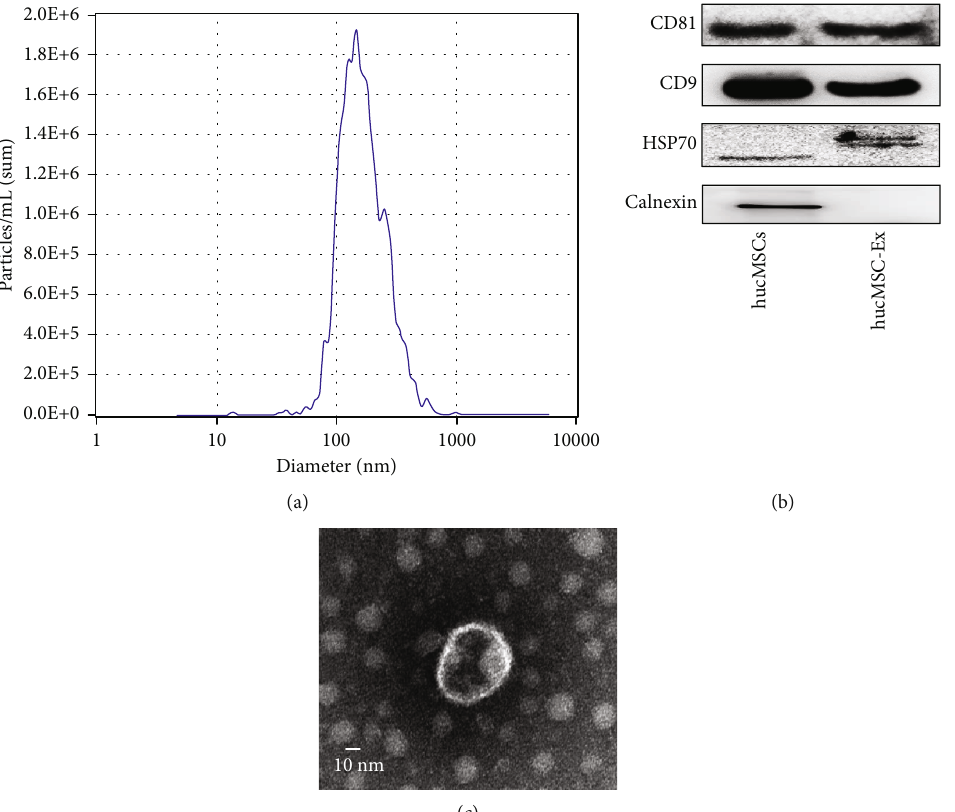
Figure 1: Identi fi cation of hucMSC-Ex. (a) The result of NanoSight nanoparticle tracking analyzer detection. (b) The morphology of hucMSC-Ex in transmission electron microscope. (c) Western blot analysis of hucMSC-Ex protein